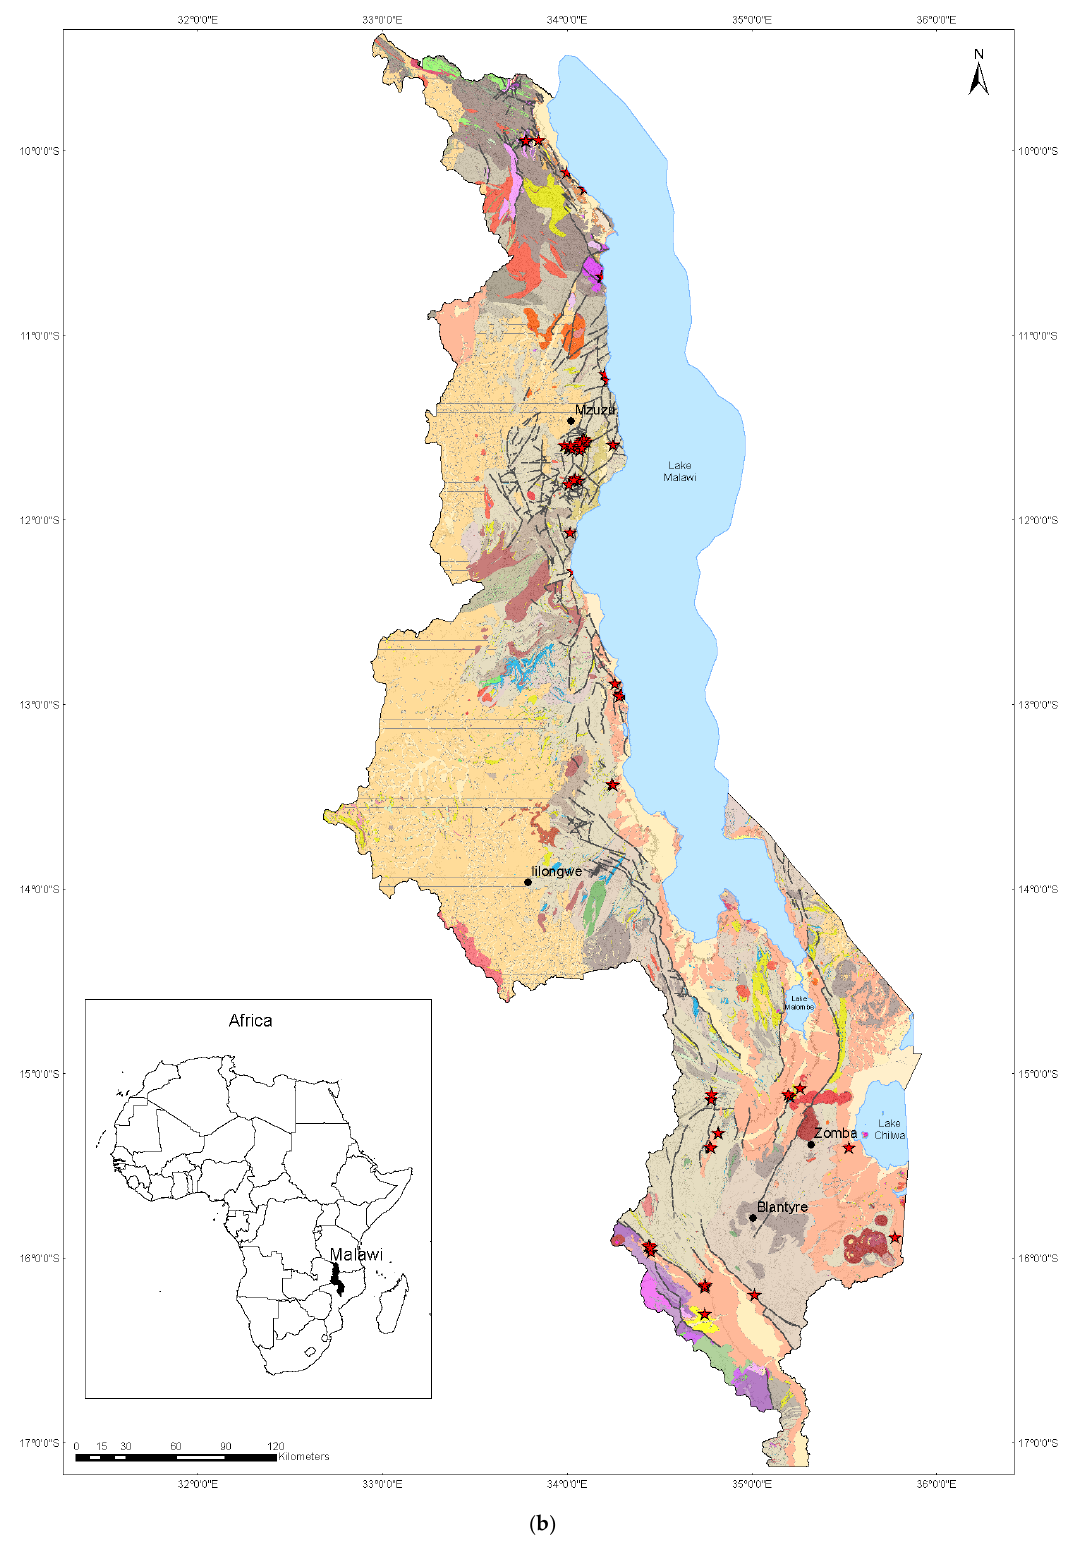
Figure 3. ( a ) Map legend and geological key for all maps, lithology organised per lithological group. ( b ) Full geological map of Malawi (digitised after others: [47,51], with Malawi’s location on the African continent inset. Map is divided into 10 separate maps with additional detail necessary to identify specific lithologies in the Supplementary Materials (Figures S1–S10).